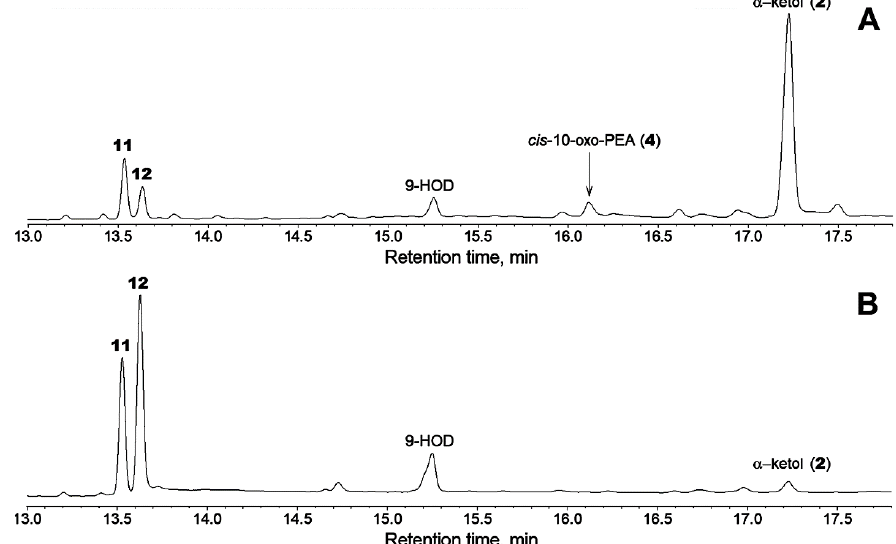
Figure 5 . The GC-MS profiles of products (Me/TMS) formed when the hexane solution of isolated allene oxide 9,10-EOD (free acid) was kept for 2 h. The 9,10-EOD was preliminarily prepared by biphasic incubation of LeAOS3 ( A ) or ZmAOS ( B ) with 9-HPOD as described in Materials and Methods.